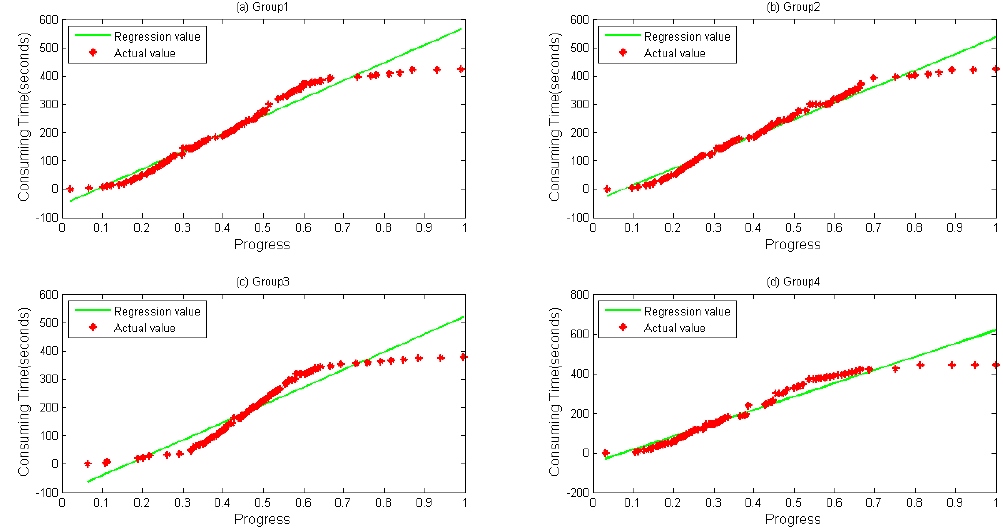
Figure 5. Linear Regression calculated by direct regression algorithm during a lifetime. ( a ) Group 1; ( b ) Group 2; ( c ) Group 3; and ( d ) Group 4 data and their values calculated by Linear Regression for Sort sample. Table 5. Error evaluation during training phase for WordCount sample.